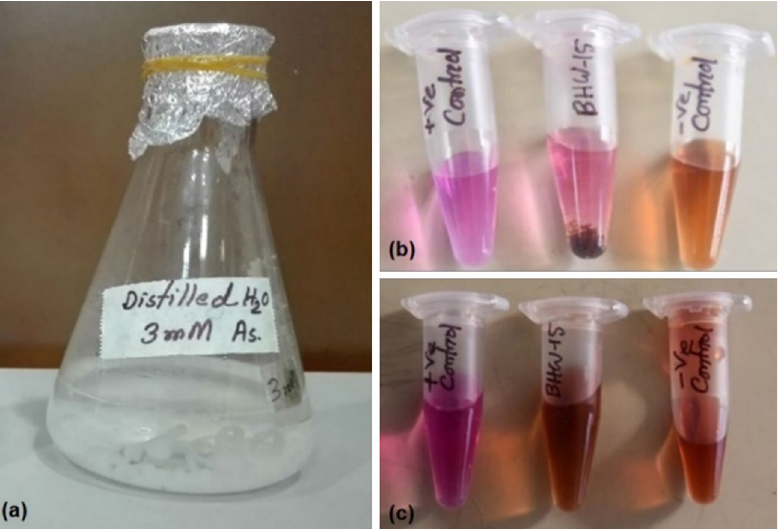
Figure 2. Immobilization of BHW15 in calcium alginate beads and incubation in arsenite containing water ( a ); phenotypic detection after 18 days ( b ); phenotypic detection after 24 days ( c ).